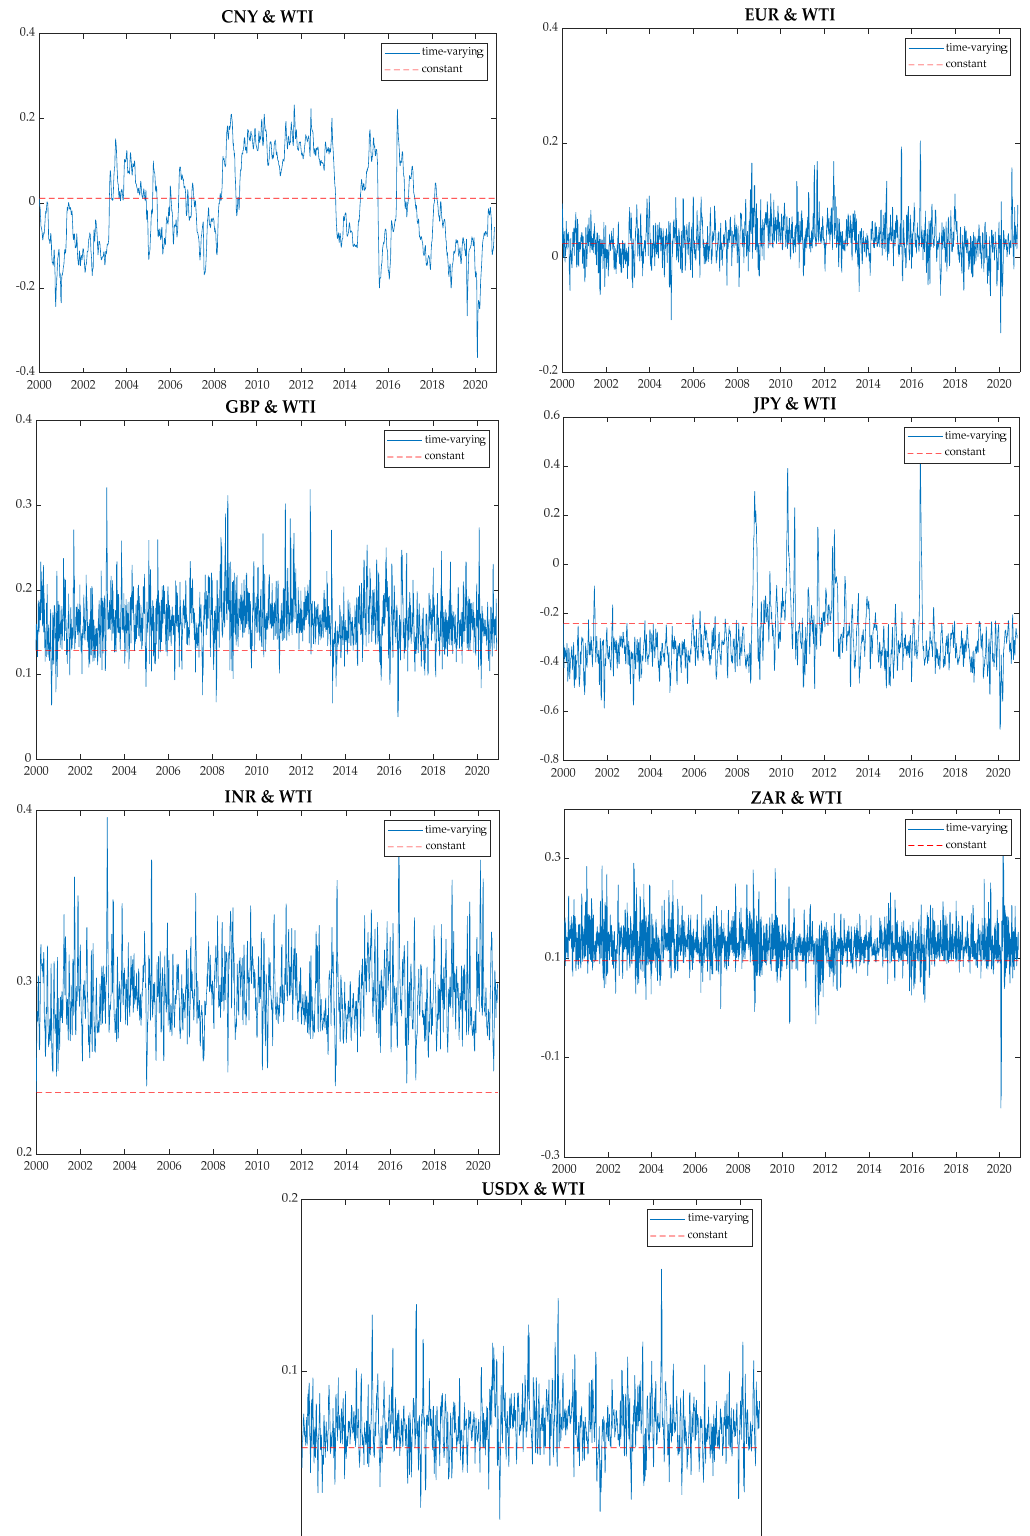
Figure 4. Time-varying dependence degree among the crude oil and exchange rates of oil importers. Note: the vertical coordinates correspond to dynamic Kendall coefficients between crude oil and exchange rate returns of each oil importer.